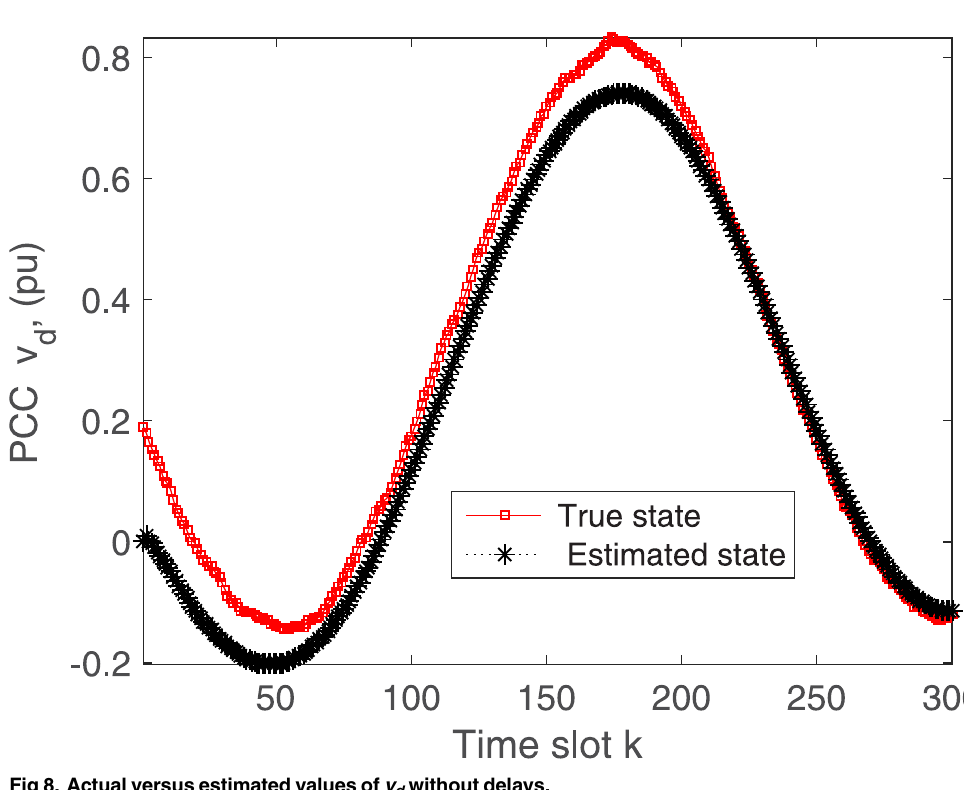
Fig 7. Actual versus estimatedvalues of i Lq without delays.